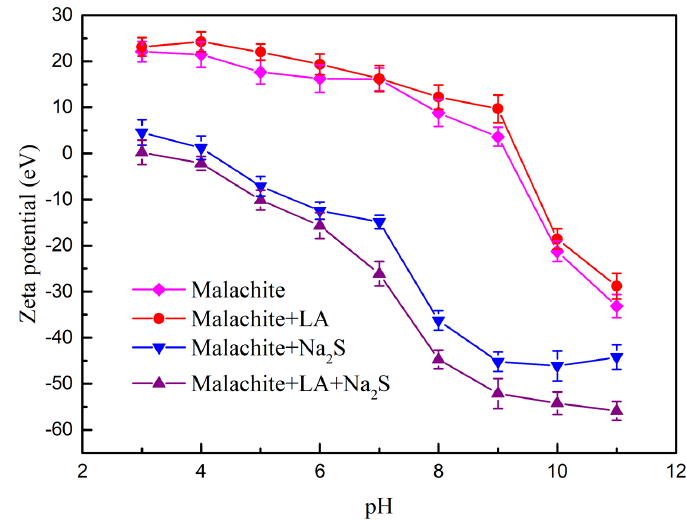
Figure 12. Zeta potential of malachite as a function of pH in the absence or presence of flotation reagent ( c (LA) = 6.0 × 10 − 5 mol/L; c (Na 2 S) = 3.0 × 10 − 3 mol/L).